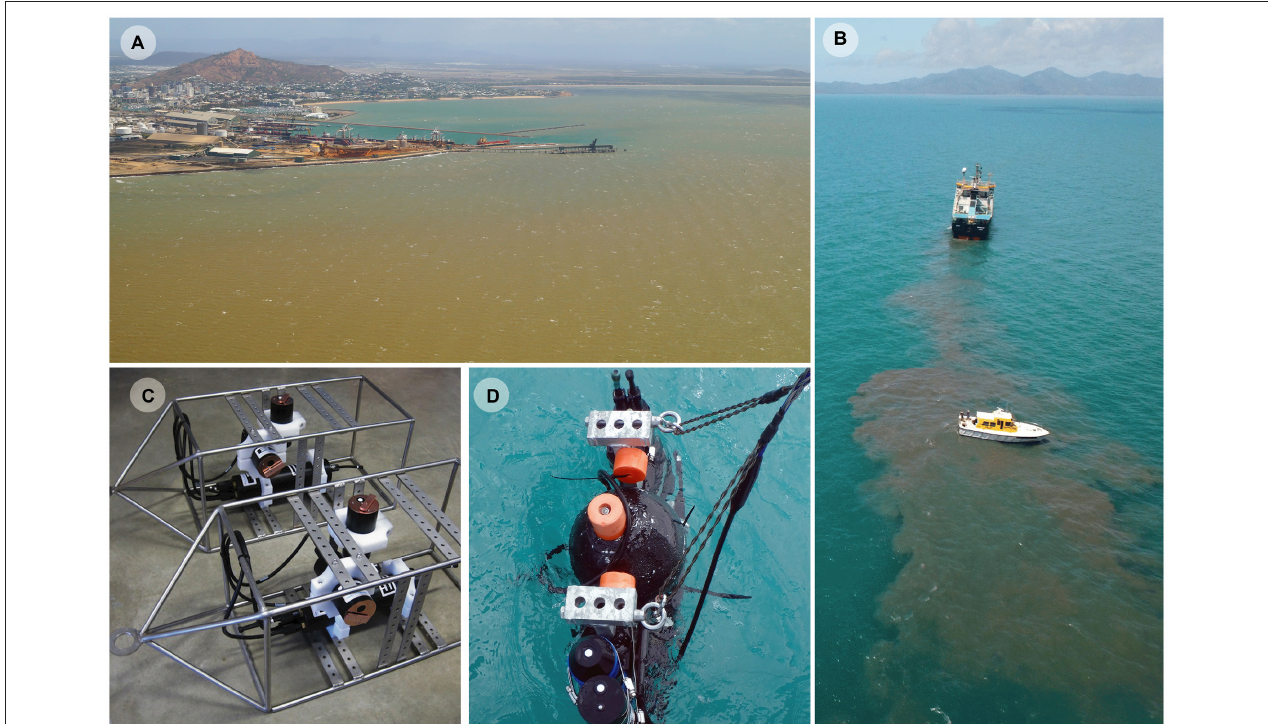
FIGURE 2 | (A) Aerial photograph of Cleveland Bay on 9 Sept 2013 during a period of elevated wind speeds. The turbidity is a natural event and not caused by dredging. (B) Research vessel with scientists vertically profiling a sediment plume from an 85m long ocean-going trailing arm suction dredge (TSHD) disposing sediment at the dredge material placement area in Cleveland Bay, (C) Two upward facing IMO–MS8 eight wavelength multispectral irradiance sensors and sideways facing IMO–NTU turbidity sensors in stainless steel frames used on the reefs at Florence Bay to measure changes in light quality, quantity and water cloudiness during natural suspension events, (D) a combined USSIMO hyper-spectral radiometer and IMO-NTU turbidity sensor which was placed in plumes generated by dredging (or dredge material disposal) and allowed to slowly sink, recording turbidity and underwater irradiance at wavelengths between 400 and 700nm.